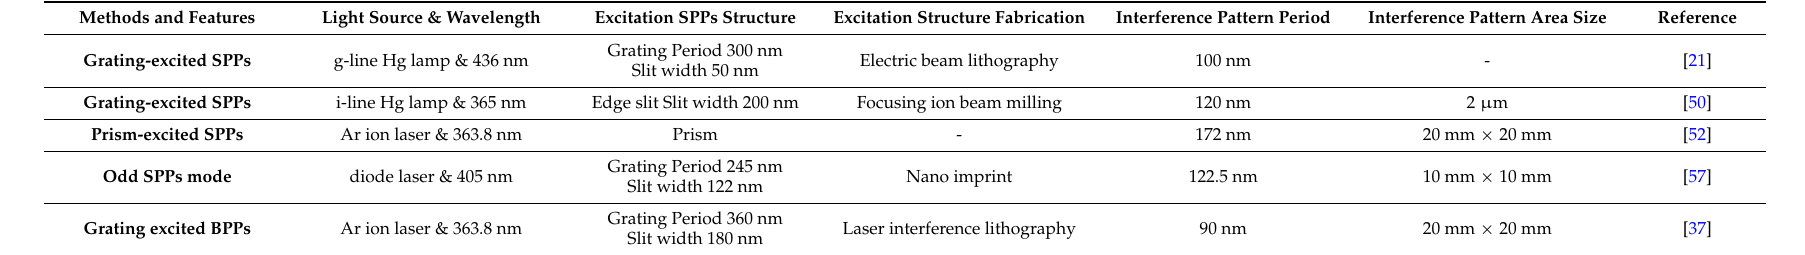
Table 1. Comparison of various plasmonic interference lithography